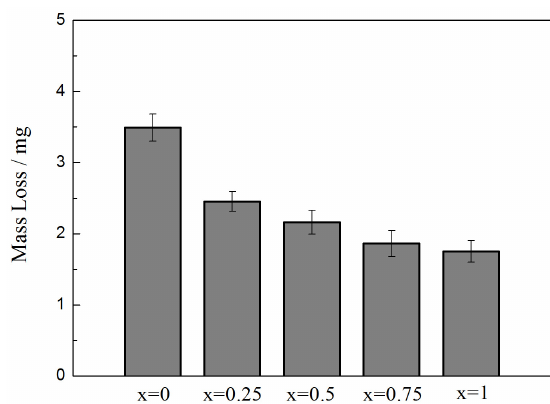
Figure6. Mass loss of FeCoCrNiAlTi x coatings .